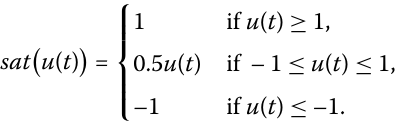
where x 1 is the rotation of the platform relative to the earth and F cos ( ω t ) = cos 3.4 cos 1.8 is the harmonic torque and a = 4/3, b = 3.776, and l = 4.6 × 10 –6 are system constant